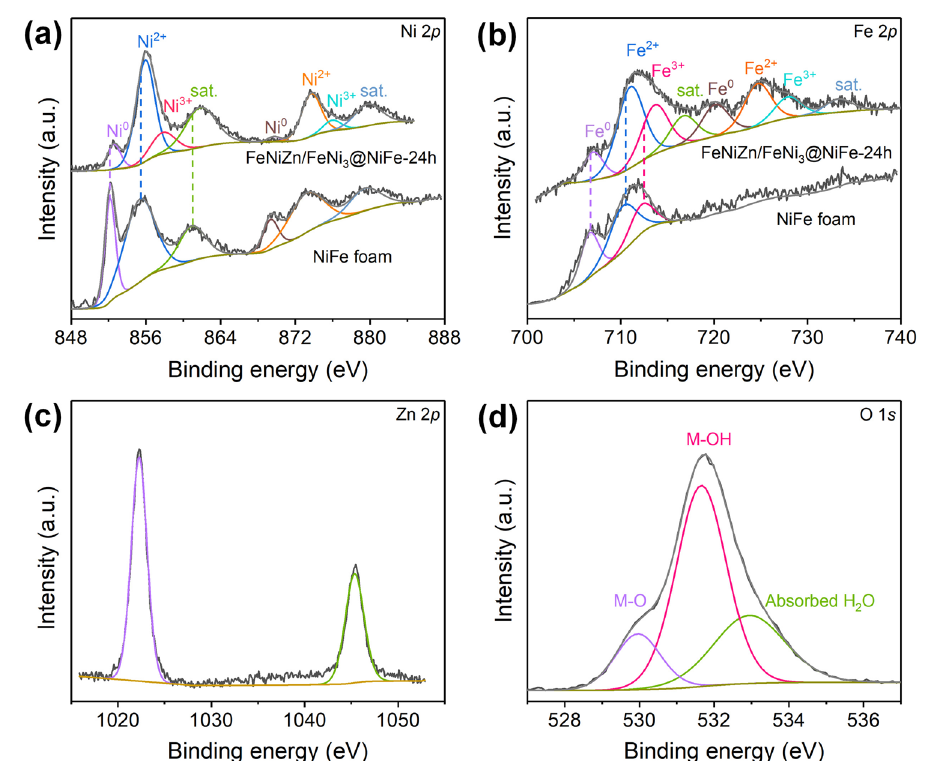
Fig. 4 XPS data of a Ni 2 p , b Fe 2 p , c Zn 2 p , and d O 1 s in the as-made FeNiZn/FeNi 3 @NiFe-24 h sample and NiFe